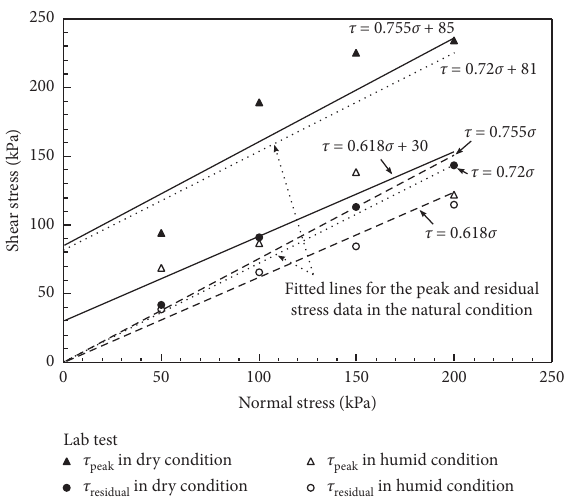
Fitted lines for the peak and residual stress data in the natural condition